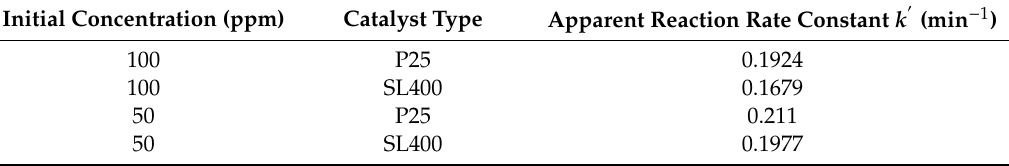
Table 4. Pseudo first order rate constants.